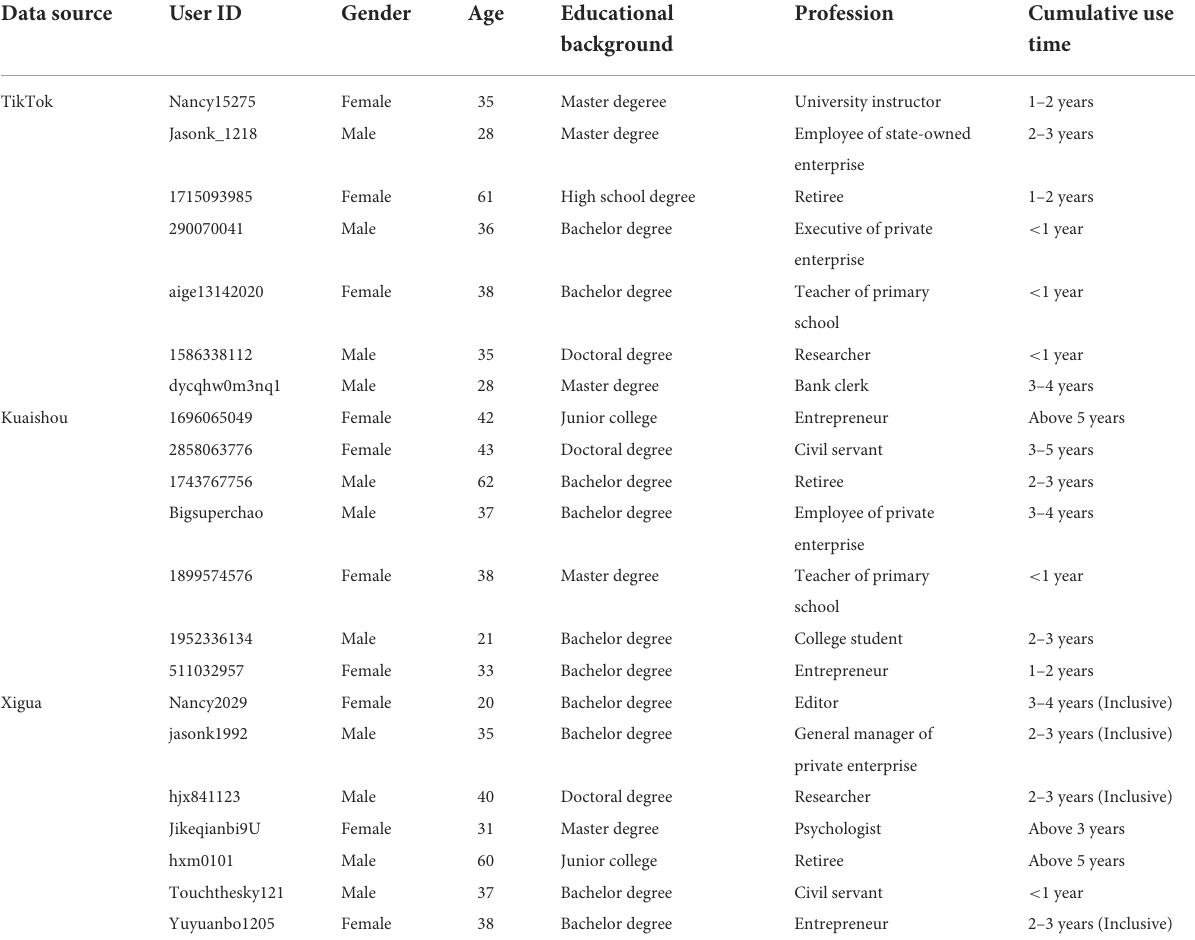
TABLE 2 Sample characteristics of an in-depth